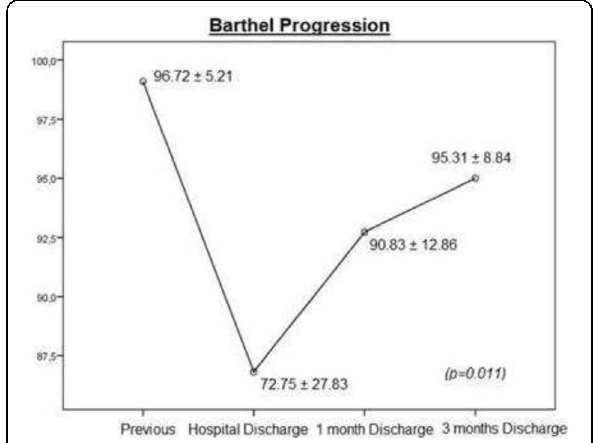
Fig. 1 (abstract 0377). Barhel Progression]